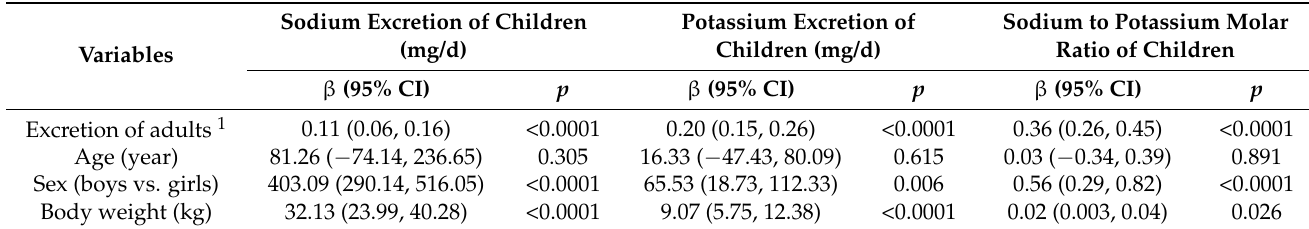
Table 3. Relationship of sodium, potassium excretion and sodium-to-potassium ratio of children with corresponding excretion of adult family members ( n = 590).